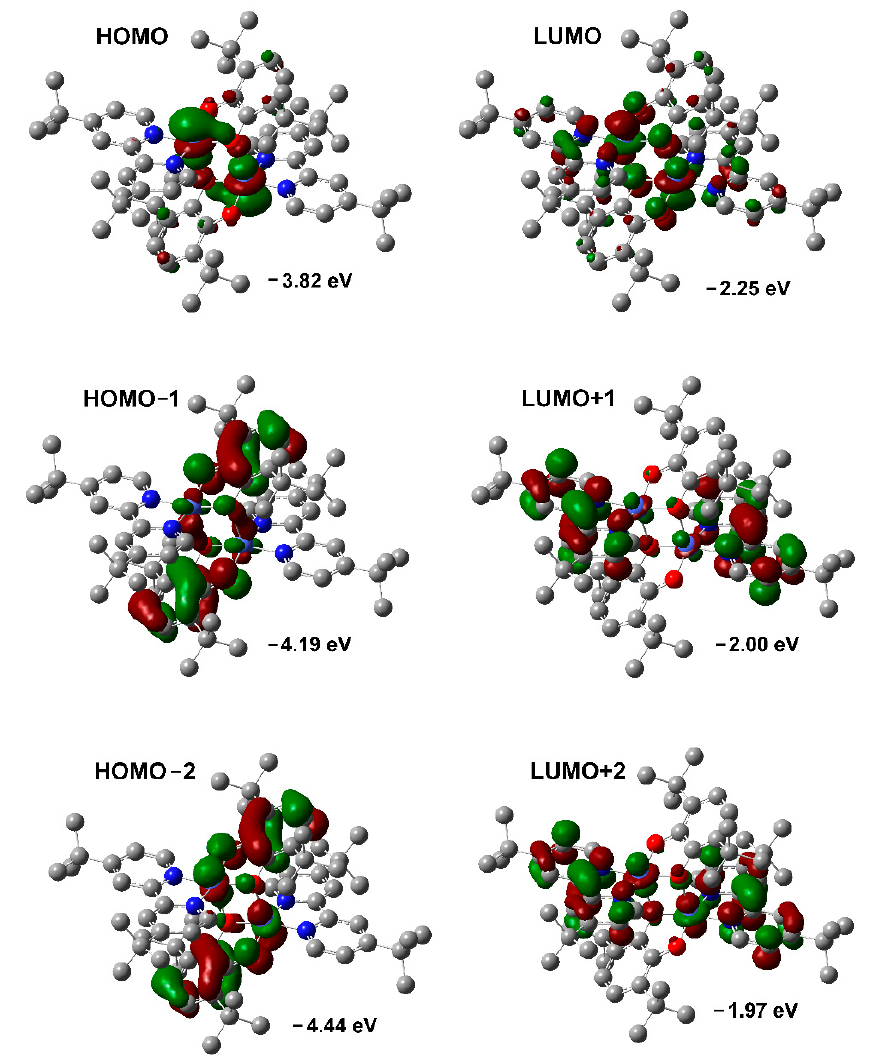
Figure 10. View of calculated frontier orbitals for complex 3 (isovalue = 0.03).